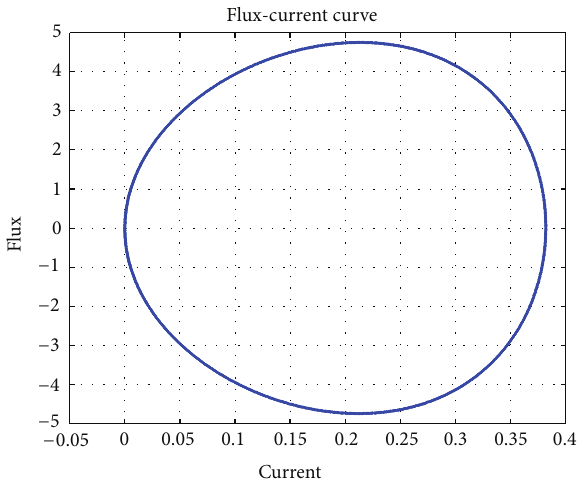
Figure 6: The meminductance curve for sinusoidal